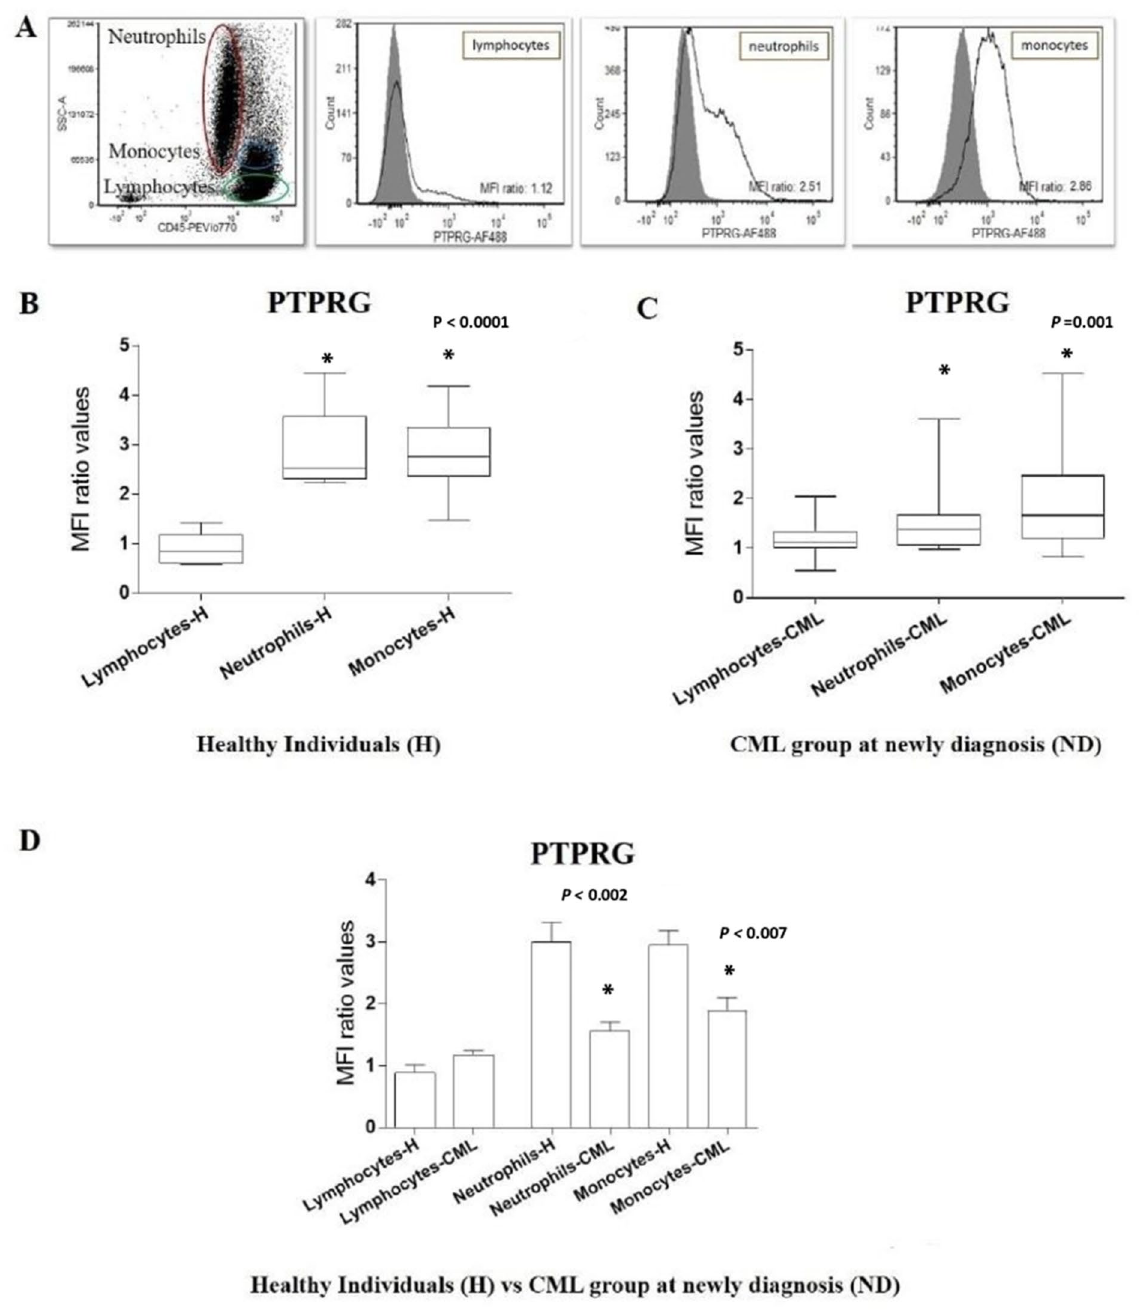
Figure 3. PTPRG protein expressions on sub-population of white blood cells of healthy individuals (H) and CML patients (ND) . ( a ) Level of PTPRG expression on sub-population of white blood cells of (H). (Y-axis) refers to count numbers of peripheral blood cells recorded in each sub-population at flow cytometry acquisition. The expression of PTPRG was reported in Mean Fluorescent Intensity (MFI). ( b ) The mean of PTPRG expression (H) on both neutrophils (mean = 3.0), monocytes (mean = 2.8) was significantly higher when compared with lymphocytes (mean = 0.89). ( c ) The median of PTPRG expression (ND) on monocytes (median = 1.7); neutrophils (median = 1.5) was significantly higher when compared with lymphocytes (median = 1.14). ( d ) PTPRG expression on neutrophils and monocytes was significantly lower in CML (ND) patients in comparison with healthy individuals